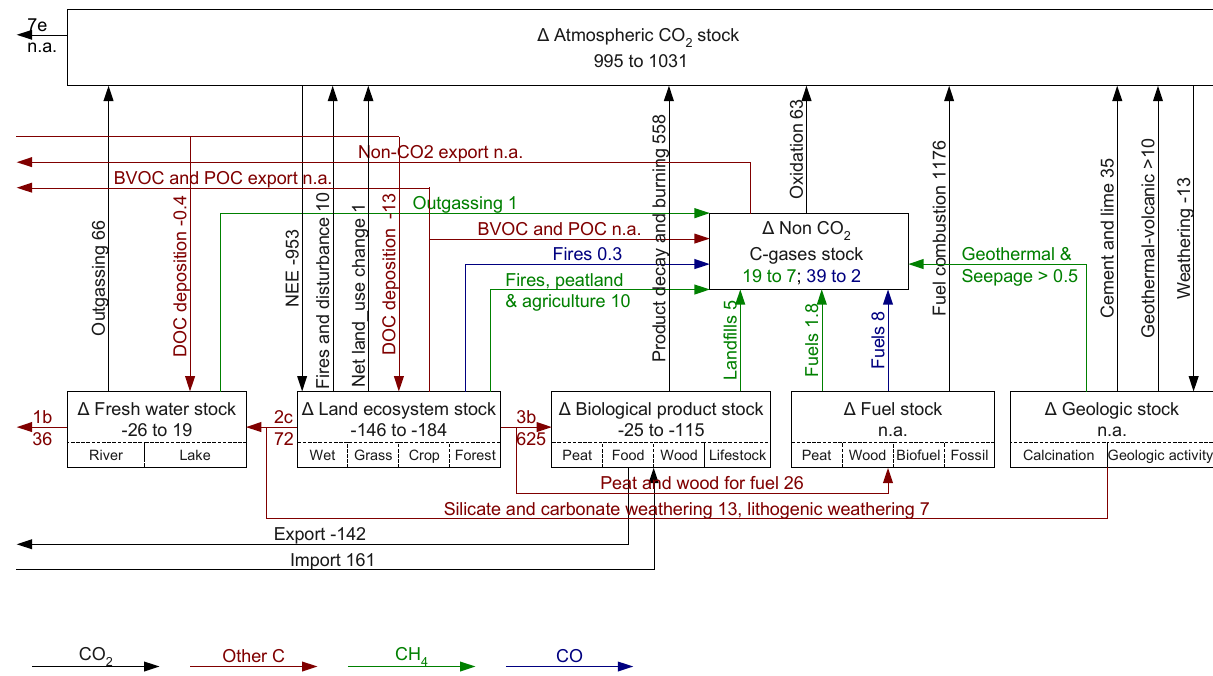
Fig. 4. European C-balance for CO 2 , CH 4 , CO and other C-compounds (Tg C yr − 1 ) based on diverse data sources including atmospheric inversions, flux measurements and stock inventories. Flux estimates were taken from Table 1, stock changes from Table 3. Black arrows indicate CO 2 fluxes, green CH 4 fluxes, blue CO and red indicates other C-fluxes. Labelling is explained in Table